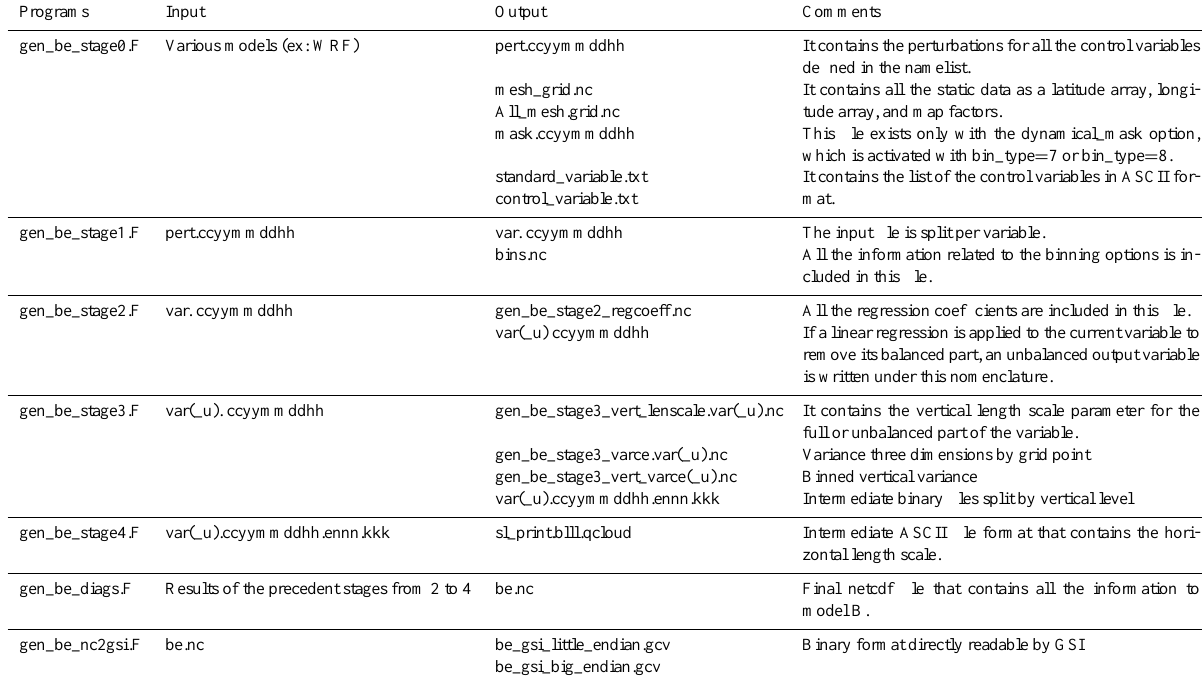
Table A2. Input and output of the different components of the GEN_BE v2.0 code.